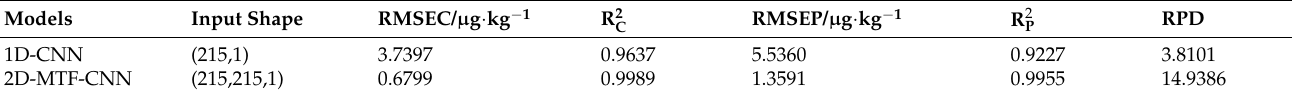
Table 3. Raman characteristic peak attribution.